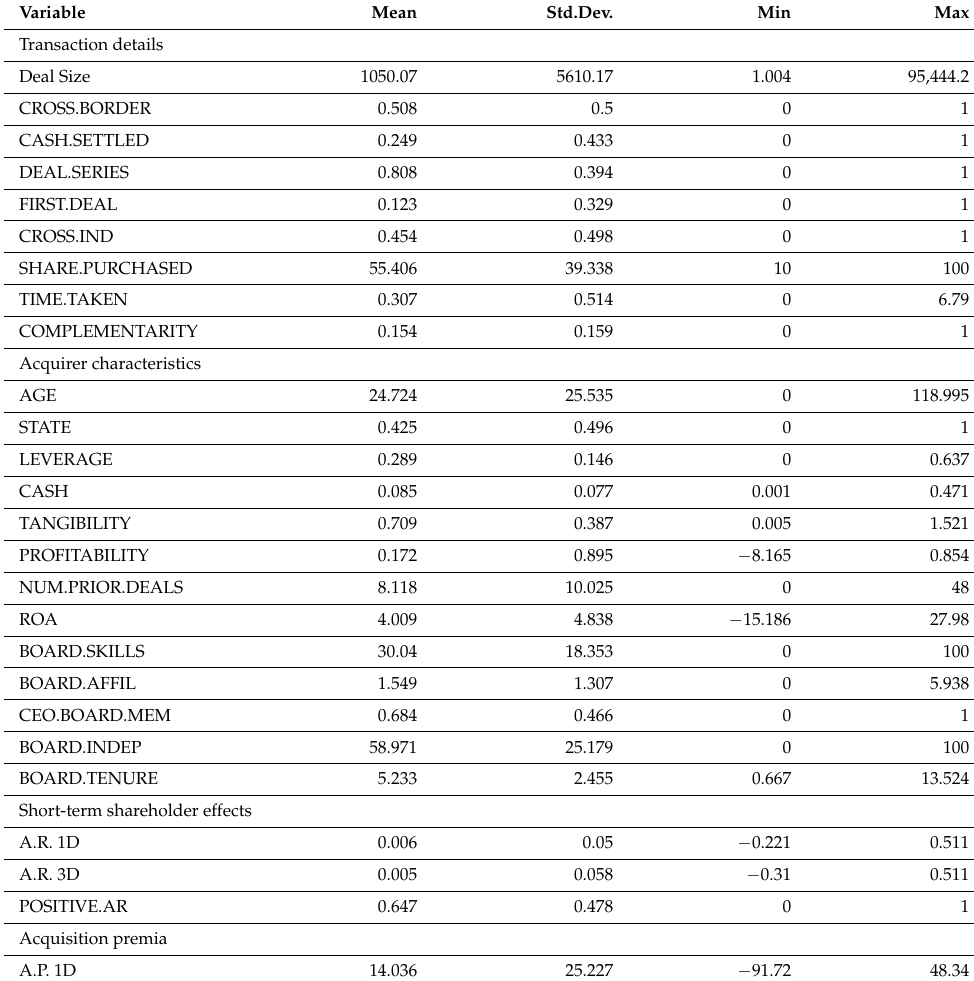
Table 2. Descriptive